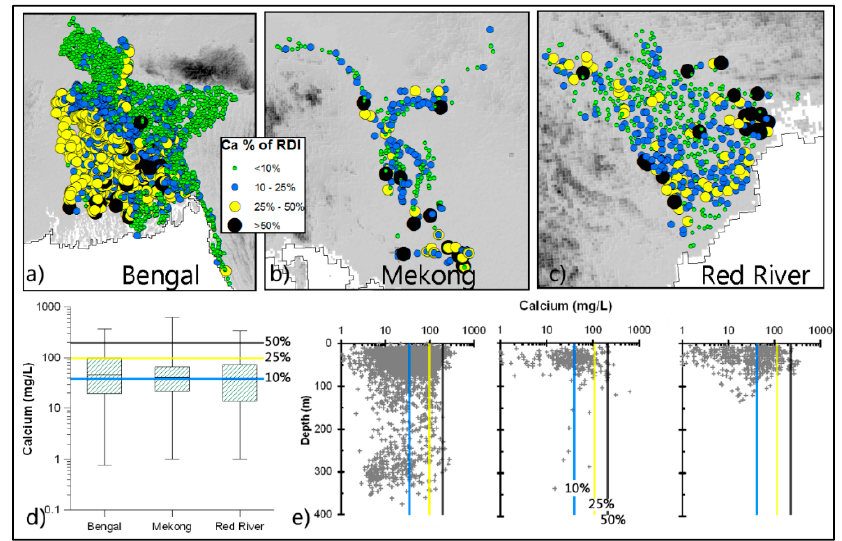
Figure 2. Concentration of Ca in groundwater in relation to RDI. Spatial ( a – c ) and vertical ( e ) variations of well-water Ca, and box plots ( d ) showing basic statistical (minimum, maximum, median, lower quartile and upper quartile) properties of well-water Ca concentration. Boxes represent IQR (25th and 75th percentile) with the line at the median.